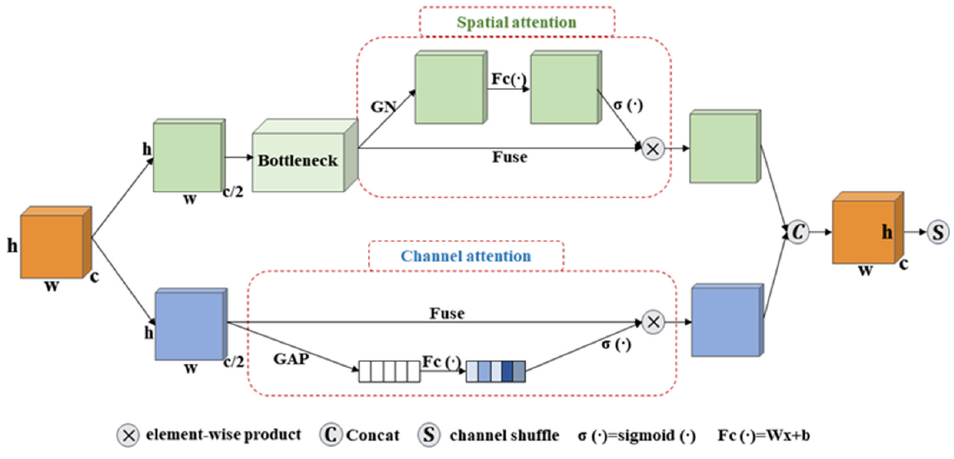
Figure 4. Structure of CSP-SA module.